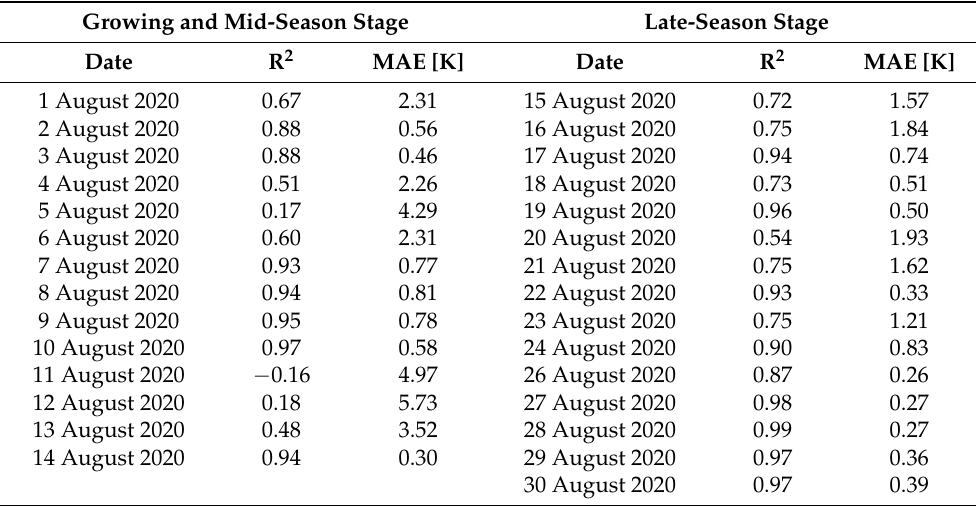
Table 3. The performance indicators R 2 and MAE evaluate the model predictions of the temperature above the canopy of an irrigated soybean crop during the middle and late-season stages. Growing and Mid-Season